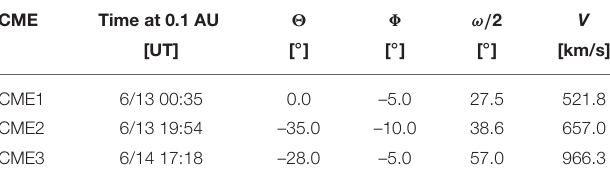
TABLE 1 | Parameters obtained from GCS reconstructions of each CME in the outer corona and used as input to the EUHFORIA cone model described in section